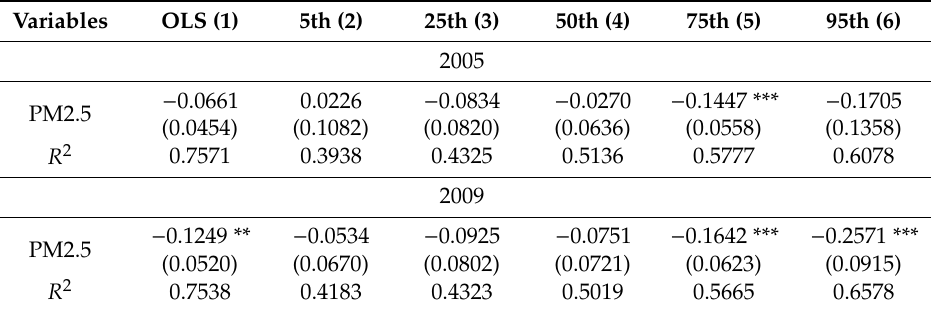
Table 3. OLS and quantile regression results for 2005 and 2009.